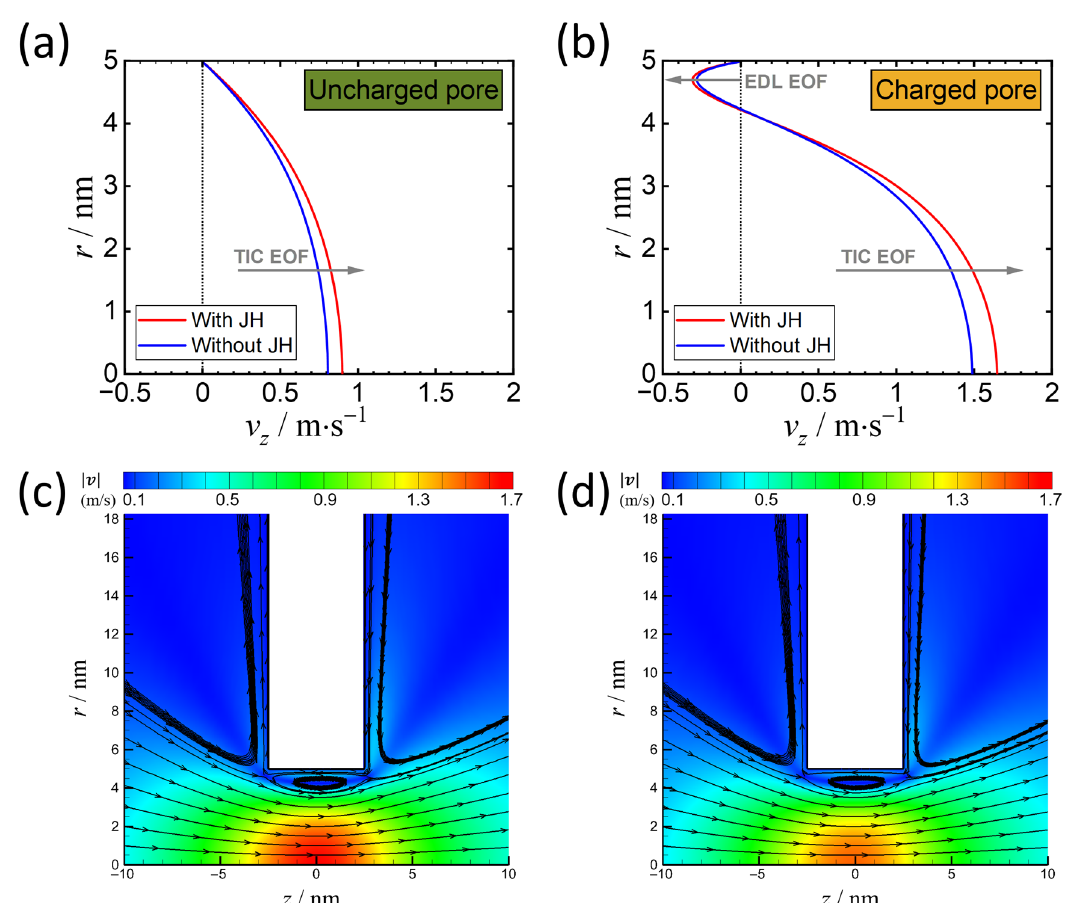
Figure 5. Velocity profiles at z = 0 in ( a ) an uncharged and in ( b ) a negatively charged nanopore. Contours of the velocity magnitude and streamlines of the two cases in ( b ) as the surface is charged: ( c ) When considering Joule heating e ff ects, and ( d ) without Joule heating e ff ects. ∆ φ = 2.0 V for all these cases and σ = − 25 mC · m − 2 for ( b – d